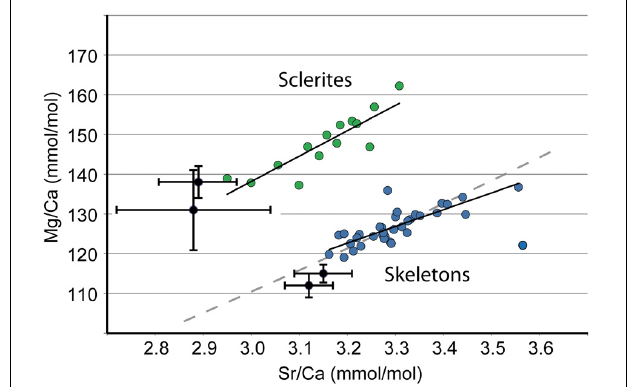
FIGURE 9 | ID-ICPMS data. Comparison of C. rubrum sclerites and skeletons. Mg/Ca vs. Sr/Ca. Sclerites: green dots. Skeletons: blue dots. Black dots are from Weinbauer et al. (2000). Gray dashed line: Rayleigh fractionation path (see text for explanation); black solid lines: best fitting lines for sclerites and